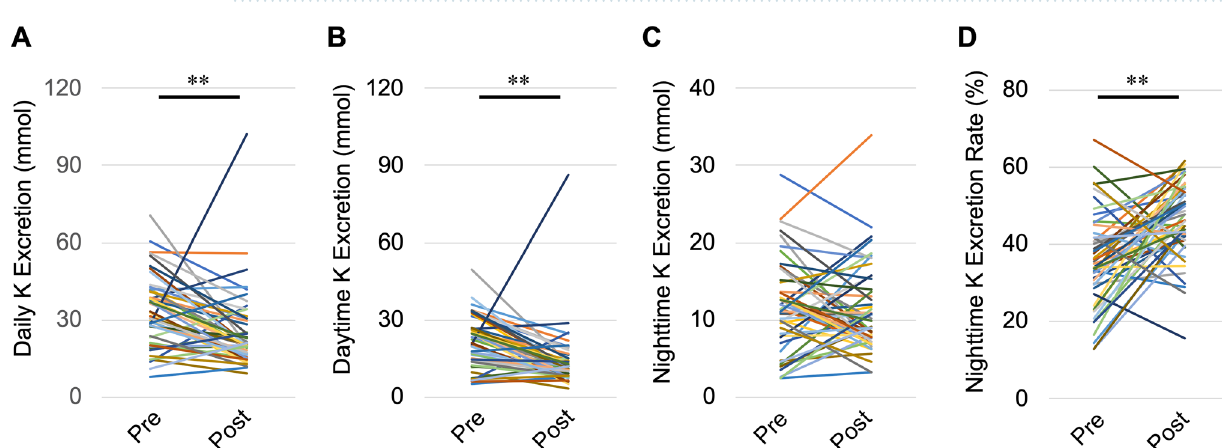
Figure 4. Changes in K excretion caused by nephrectomy. ( A ) Daily K excretion, ( B ) daytime K excretion, ( C ) nighttime K excretion, and ( D ) the nighttime K excretion rate. Pre preoperative, Post postoperative, K potassium. ** P < 0.01, by the paired t